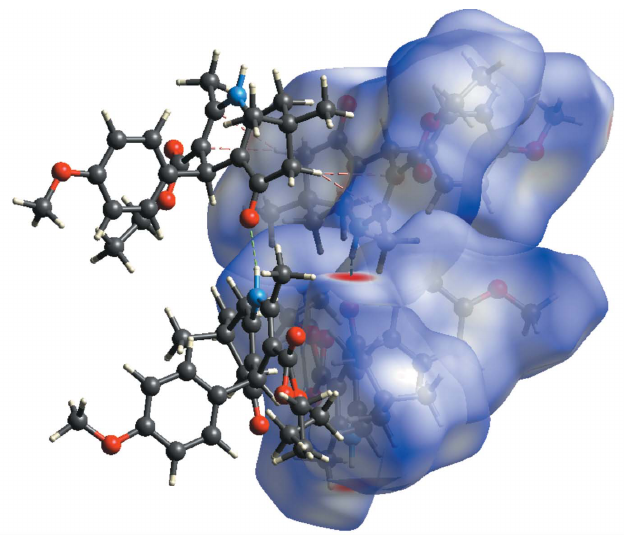
Figure 9 Hirshfeld surface of II mapped over d norm . Short and long contacts are indicated as red and blue regions, respectively. Contacts with distances approximately equal to the sum of the van der Waals radii are colored white. A (cid:3) – (cid:4) interaction (C6 A —H6 AB to double bond C2 A C3 A ) is shown as red dashed lines. Hydrogen bonds between N—H and O are shown as green dashed lines.